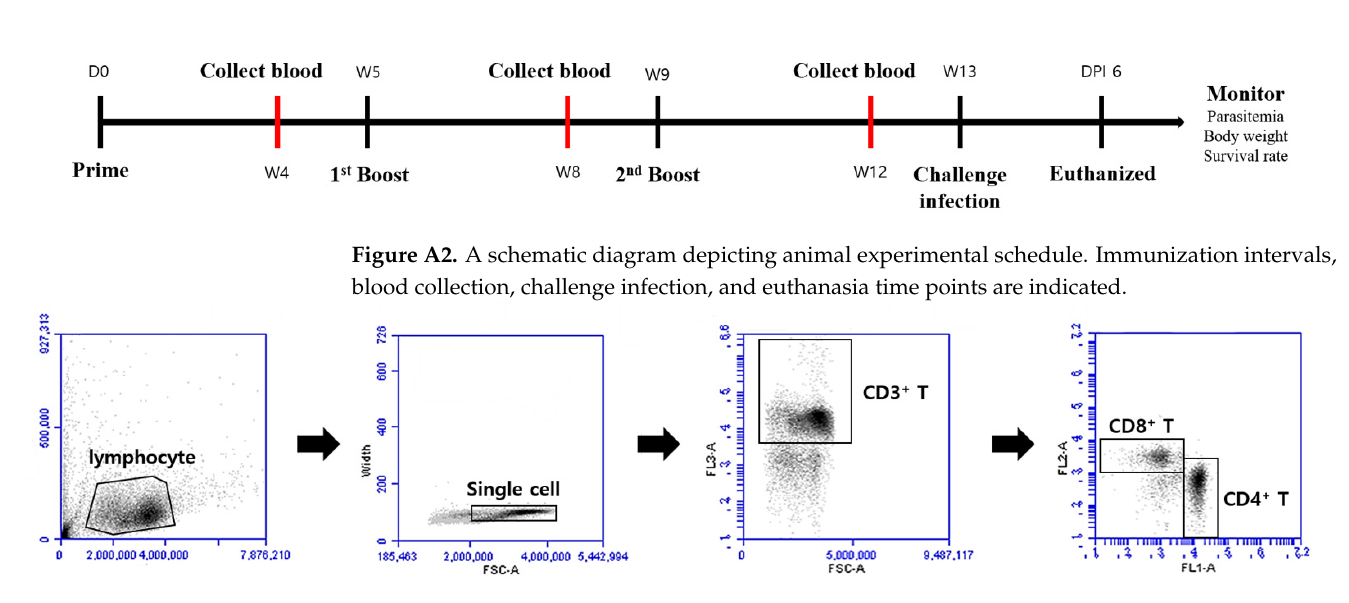
Figure A1. The diagram of the Plasmodium organism. The diagram describes the Plasmodium organism and the specified target gene (AMA1, MIC).